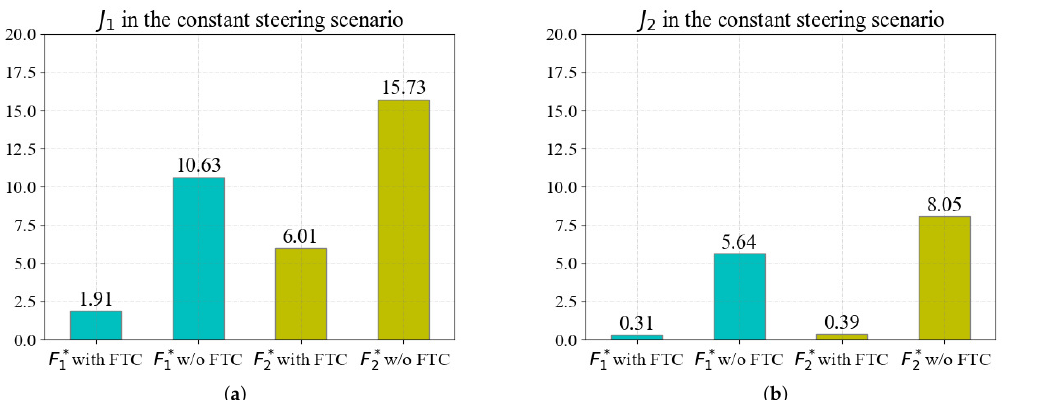
Figure 11. The evaluation in the constant steering scenario with FTC algorithm and without FTC algorithm: ( a ) J 1 in the constant steering scenario; ( b ) J 2 in the constant steering